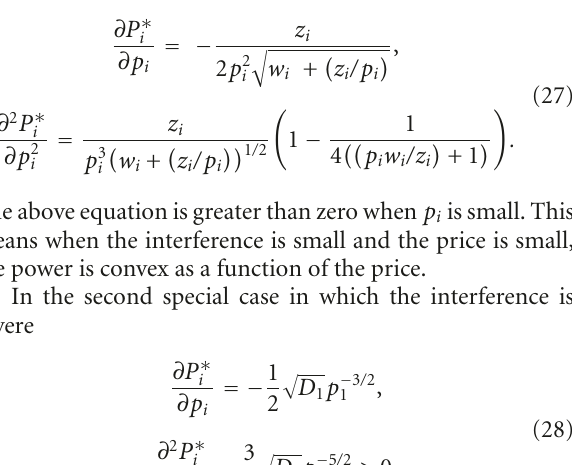
Figure 6: U 2 versus the prices of both users.